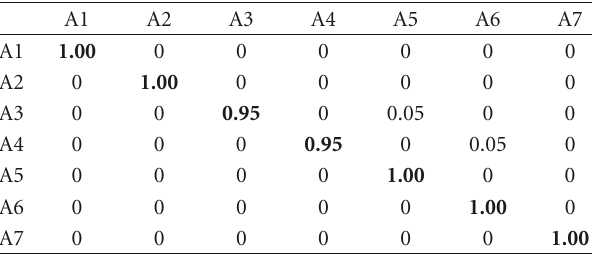
Table 2: Confusion matrix at resolution level 5.